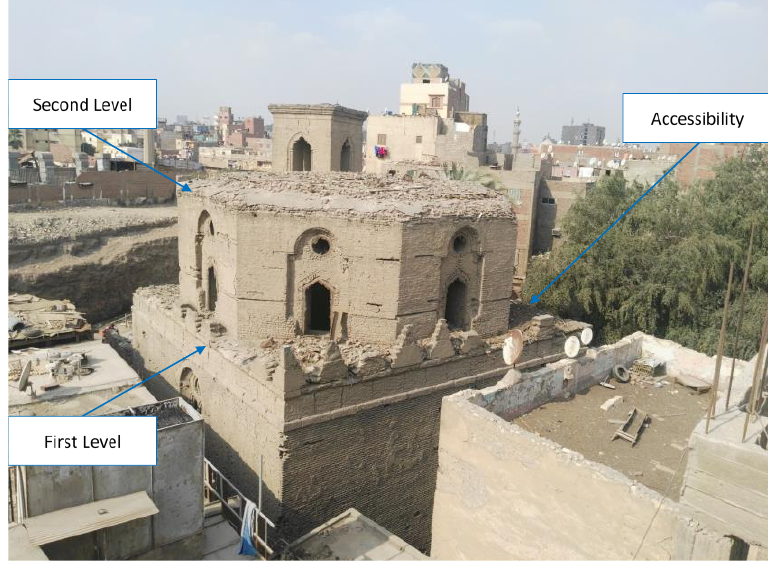
Figure 3. Elevation levels (looking north).